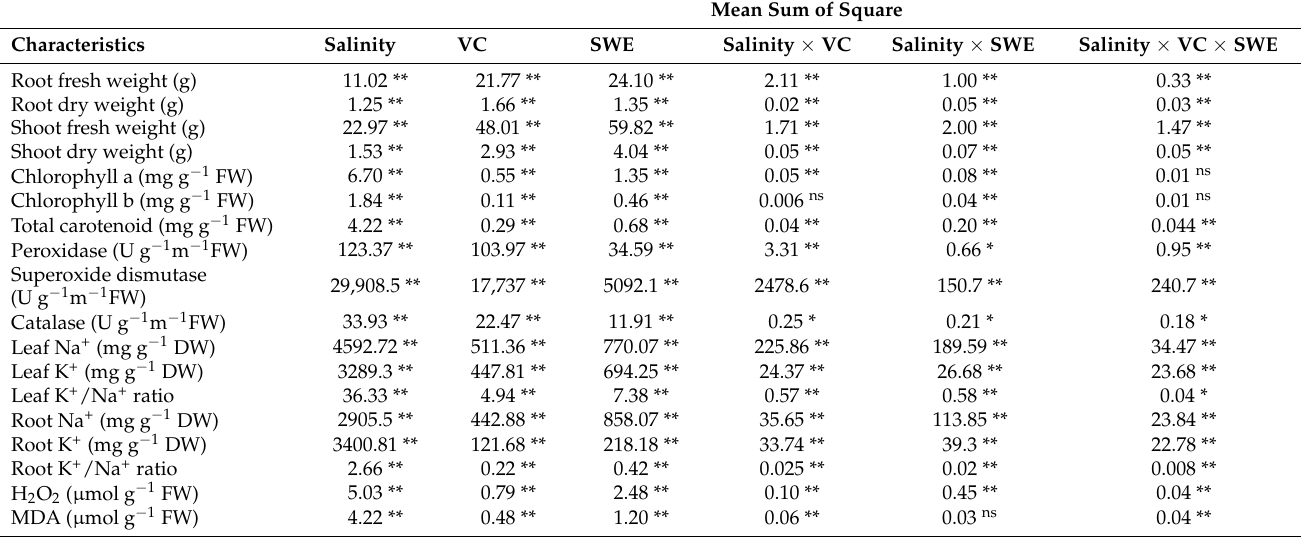
Table 1. Mean sum of square summary related to the effect of vermicompost and foliar-applied sorghum water extract on morphological attributes, photosynthetic pigments, enzymatic antioxidants, ionic contents, and H 2 O 2 and malondialdehyde (MDA) contents.